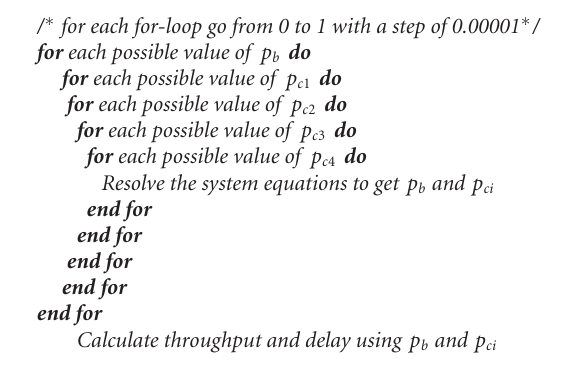
Algorithm 1: Full search for the